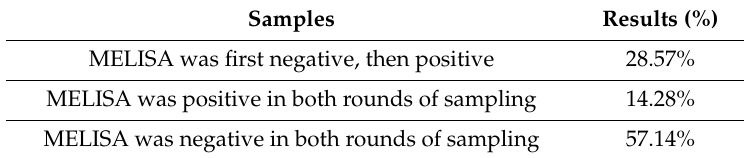
Figure 7. Changes in the MELISA sample-to-positive ratio (S / P%) in a longitudinal study (28 BTMs from 14 sheep herds). Table 4. MELISA status (positive / negative) of BTMs from 14 sheep herds in a longitudinal study.